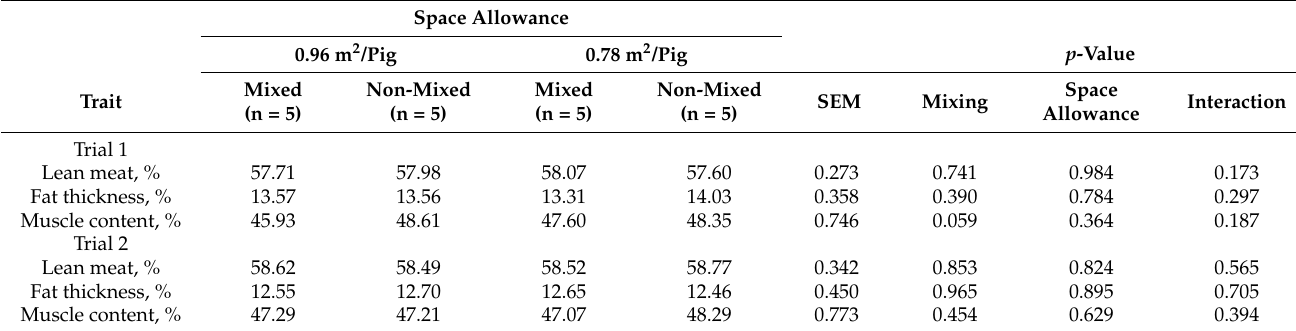
Table 5. Effect of space allowance and mixing on lean meat %, fat thickness and muscle content (Least square means (LS means) ± Standard error mean (SEM)) from trial 1 and 2 1 .